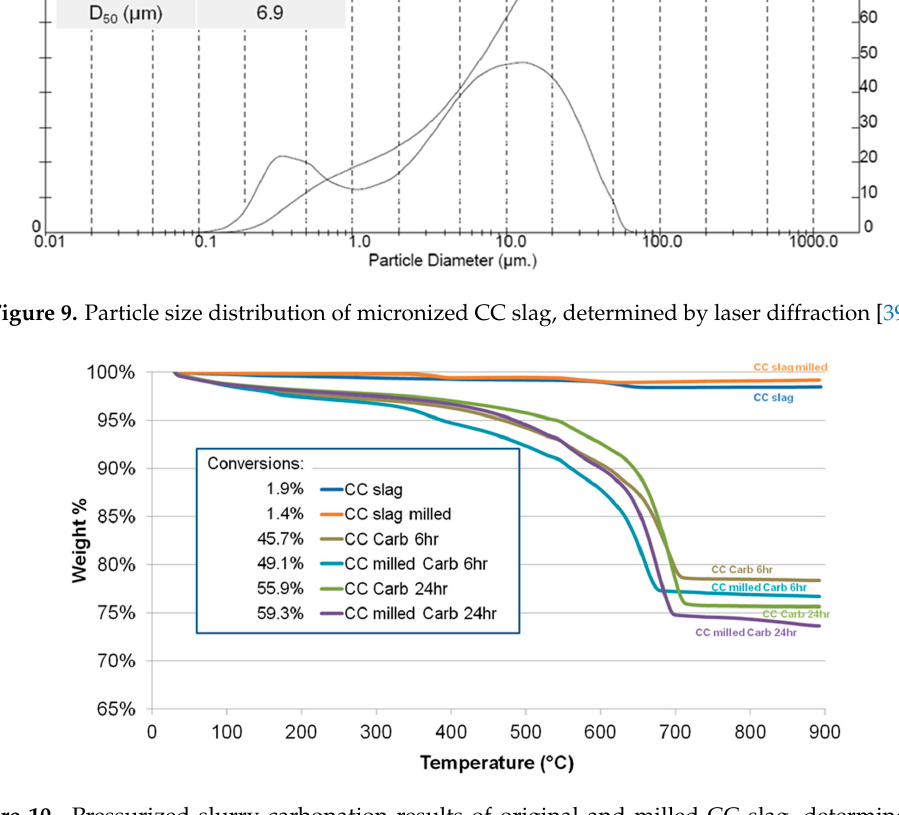
Figure 9. Particle size distribution of micronized CC slag, determined by laser diffraction [39].